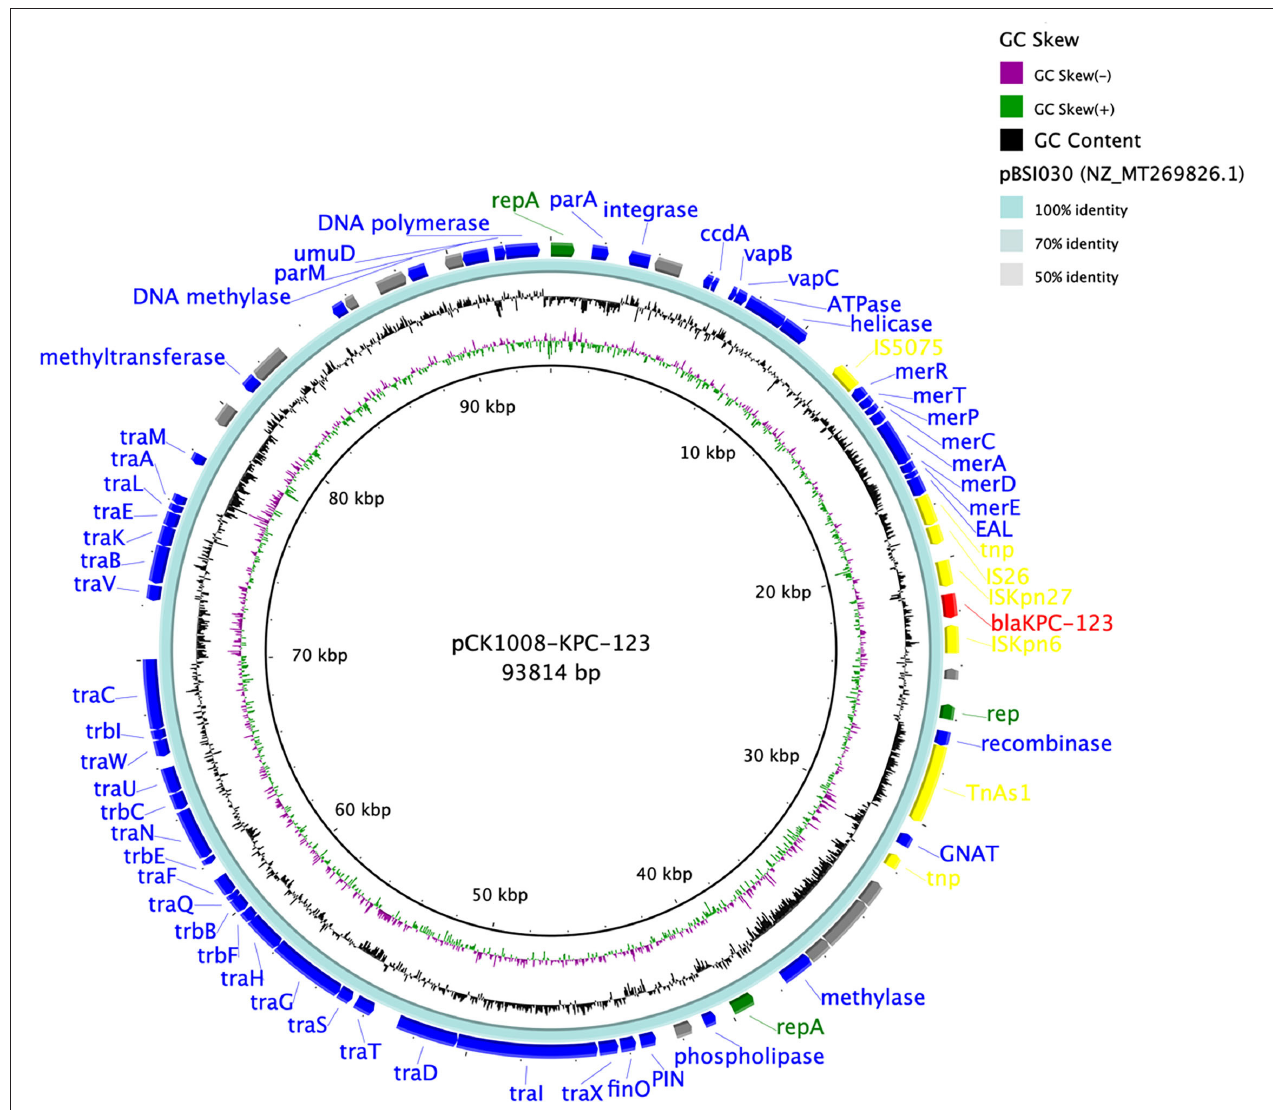
FIGURE 1 | Comparison of the bla KPC − 123 -carrying plasmid pCK1008-KPC-123 with the reference plasmid. There were five circles from the inner to the outside that displayed the scale in kilobase pairs, the GC skew, the GC content, the similarity of the reference plasmid, and the annotation of the plasmid in our study, respectively. The antimicrobial resistance genes were labeled as red and the mobile genetic elements were labeled as yellow.